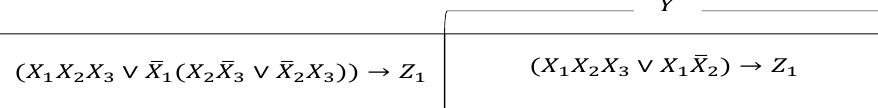
Fig. 14. The function ℎ(𝑿, 𝒀, 𝒁) = 𝑡 → 𝑠 in Example